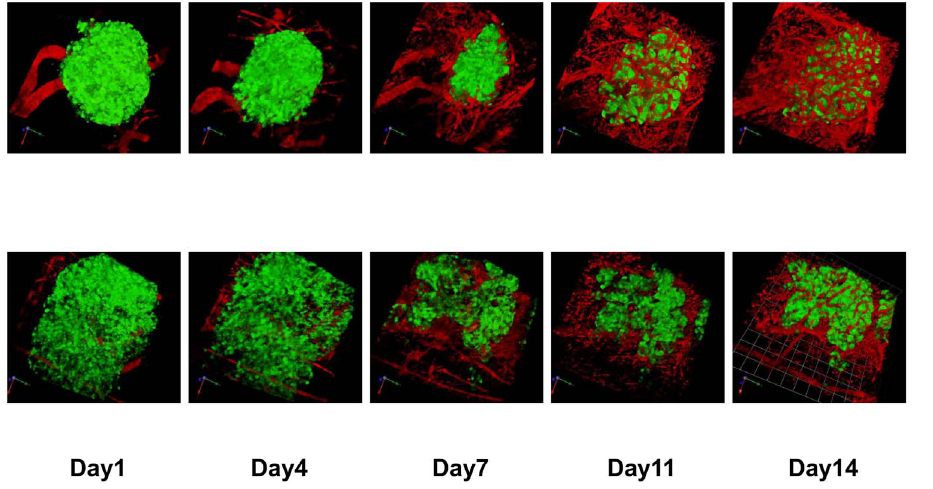
Figure 3. Imaging of the transplanted islets and surrounding blood vessels. Overlay of GFP fluorescence (pancreatic islets) and Texas Red fluorescence (blood vessels). Upper row: islets in the control group, Lower row: islets in the tacrolimus-treated group. GFP and Texas Red were excited at 890 nm. The scale bar indicated 51.0 m m/unit.